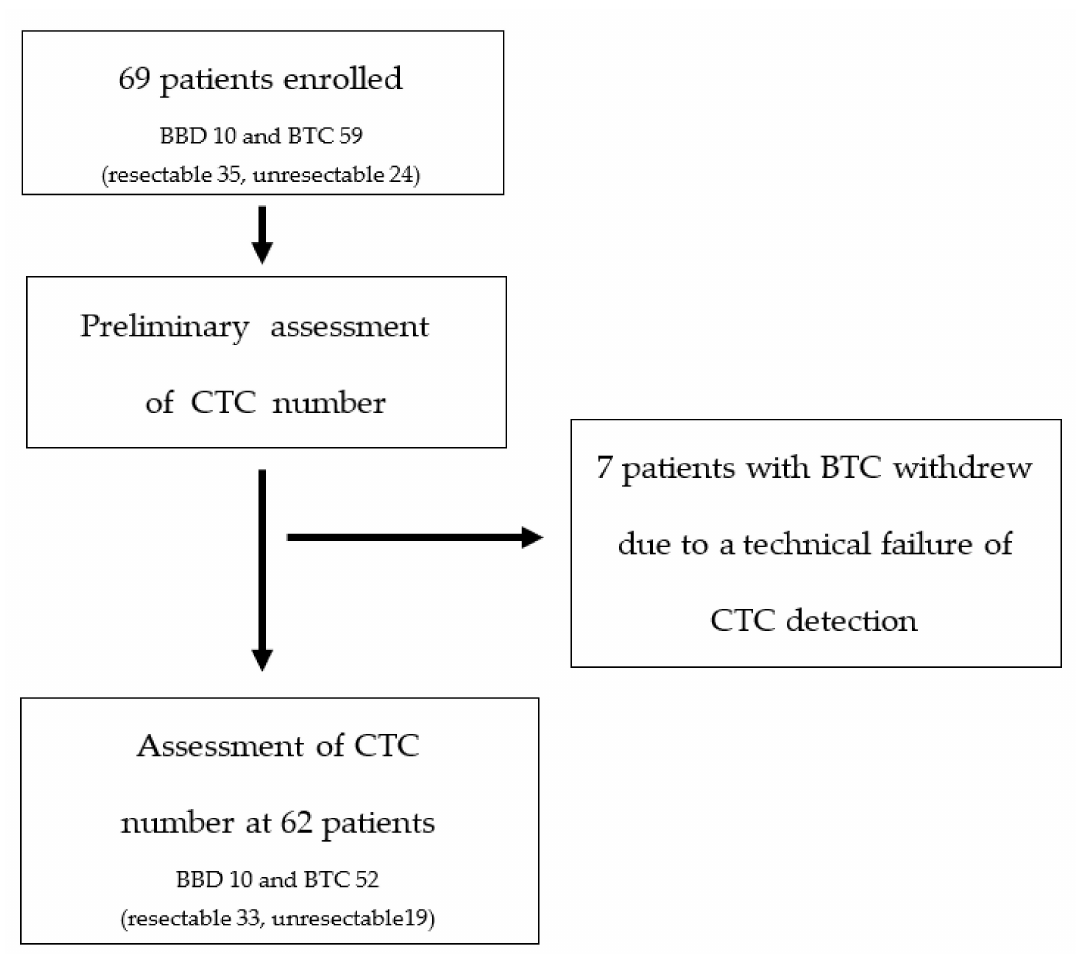
Figure 1. Flow chart of the study. BBD; benign biliary disease, BTC; biliary tract cancer, CTC; circulating tumor